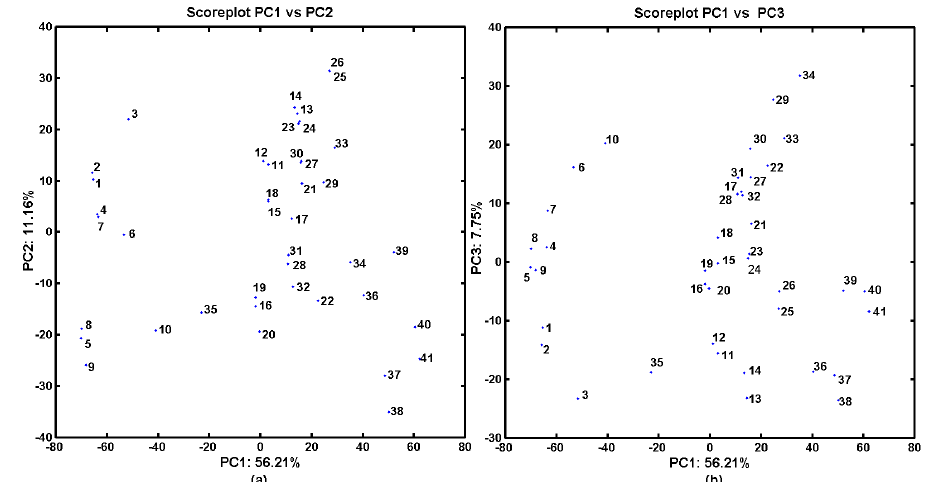
Figure 2. Projection of carbamates 1 – 41 on a plane defined by two principal components for the Dragon descriptors: the first vs. second ( a ); and the first vs. third ( b ).